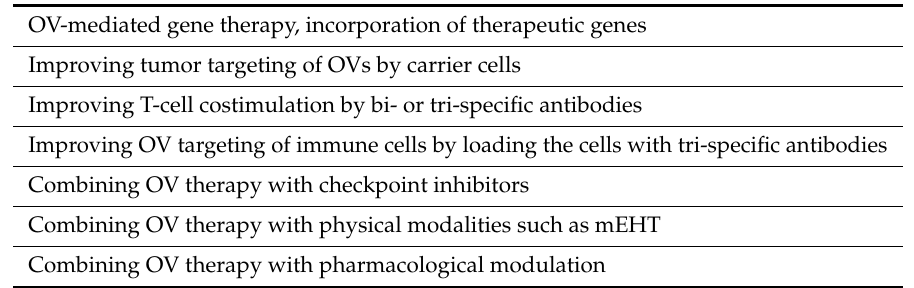
Table 6 contains a summary of future concepts and perspectives of OV-mediated therapy. Table 6. Future